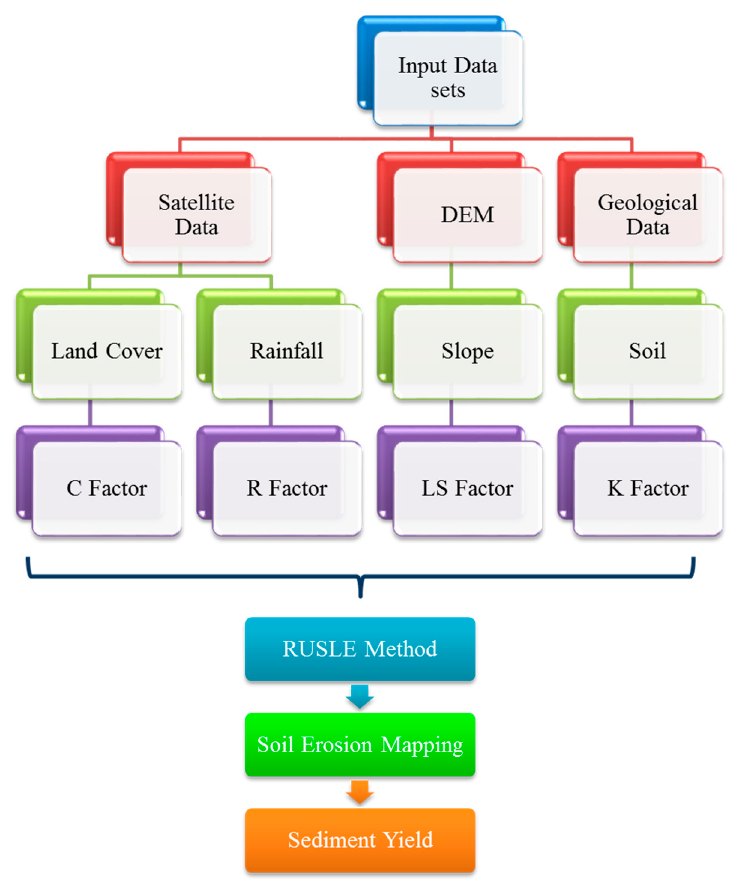
Figure 3. Workflow chart of the study. (DEM(Digital Elevation Model),C Factor(Cover management), R Factor(Rainfall erosivity), LS Factor(Slope length-gradient), K Factor(Soil erodibility), RUSLE(Revised Universal Soil Loss Equation)).